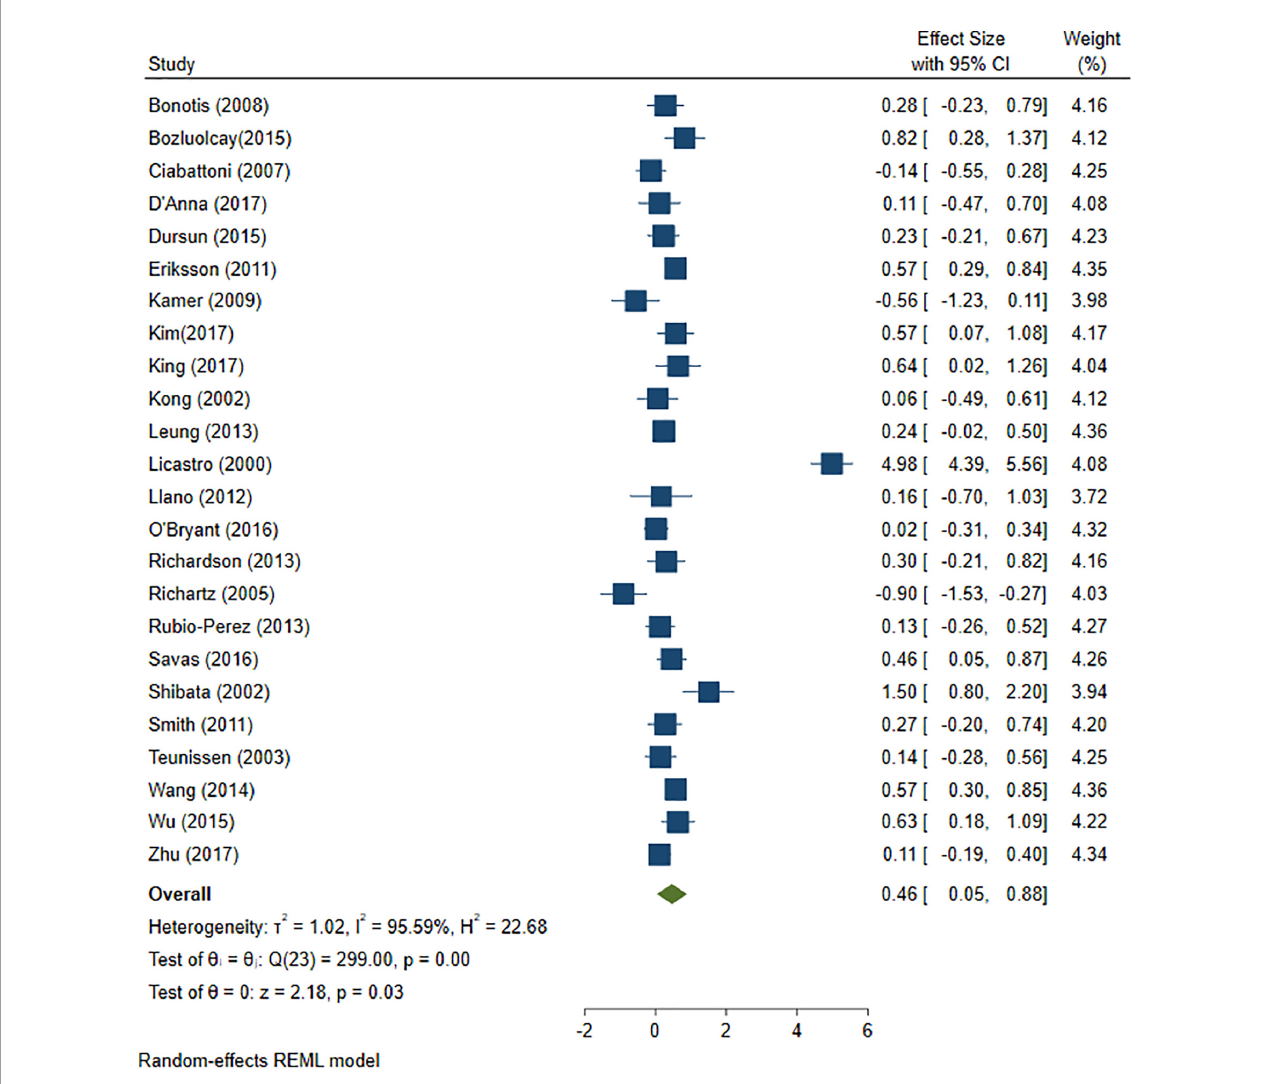
FIGURE4 Forest plot of pooled Hedge’s g depicting high IL-6 concentration in Alzheimer’s disease (AD) samples compared to controls.